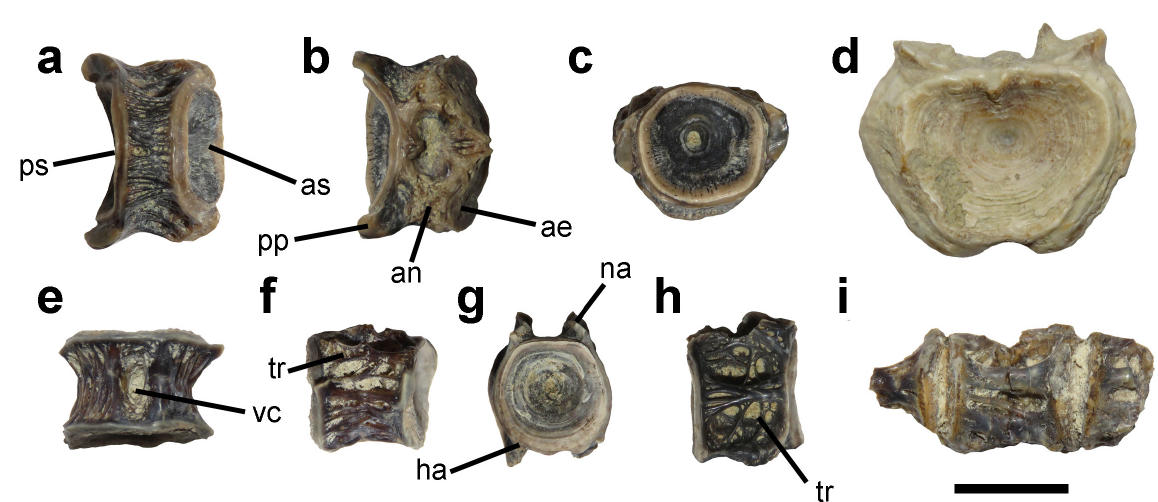
Figure 5. Percichthyidae genus and species indeterminate. Vertebrae. a-c, first precaudal vertebral centrum (LIEB- PV 8000) in a, ventral; b, dorsal; c, anterior; d, large-sized precaudal vertebral centrum (LIEB-PV 8001) in anterior view; e-f, precaudal vertebral centrum (LIEB-PV 8001) in e, ventral, and f, right lateral views. g-h, caudal vertebra (LIEB-PV 8001) in g, anterior; h, right lateral views. i, three articulated caudal vertebrae (LIEB-PV 8000) in lateral view. h-k, basioccipital (LIEB-PV 8009) in h, ventral; i, dorsal; j, left lateral; and k, posterior views. References: ae, articular surface for the exoccipital; an, articular surface for the neural arch; as, anterior articular surface; ha, haemal arch; na, neural arch; pp, posterior porcess; ps, posterior articular surface; tr, trabecular bone; vc, ventral concavity. Scale bar: 1